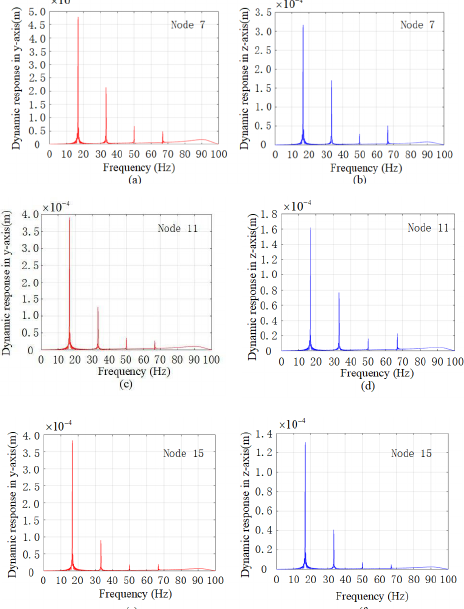
Figure 15. The mathematical simulated dynamic response with 0.4 mm parallel misalignment and 0.2 ◦ angular misalignment of nodes 7, 11, and 15 in the y -axis and z -axis. ( a ) Node 7 in the y -axis. ( b ) Node 7 in the z -axis. ( c ) Node 11 in the y -axis. ( d ) Node 11 in the y -axis. ( e ) Node 15 in the y -axis. ( f ) Node 15 in the z -axis.